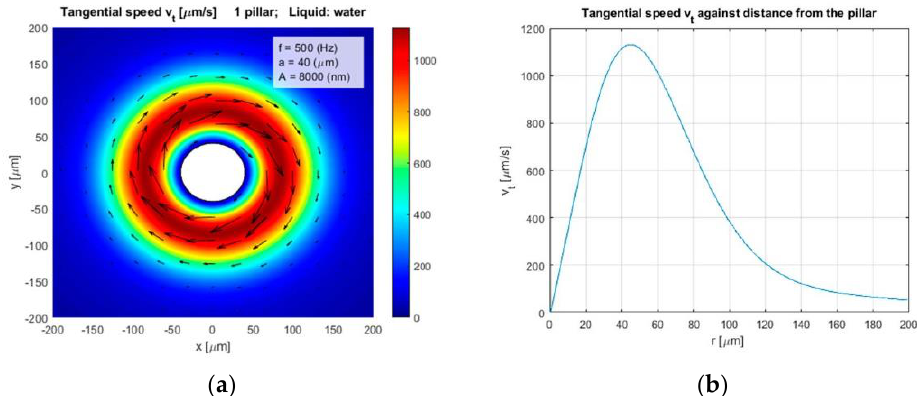
Figure 4. ( a ) Tangential velocity of water stream 𝑣 𝑡 , and ( b ) its amplitude as a function of distance from the pillar.